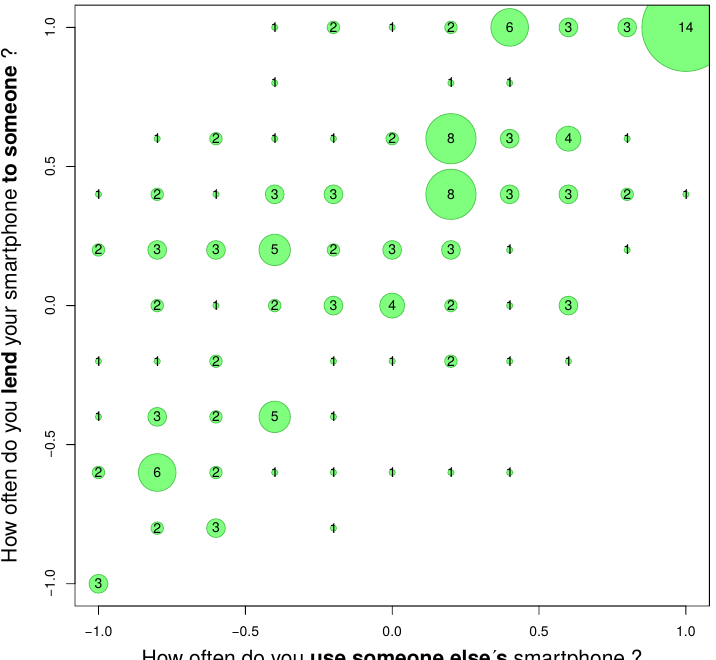
Figure 3. Associations “How often do you use someone else’s smartphone?” and “How often do you lend your smartphone to